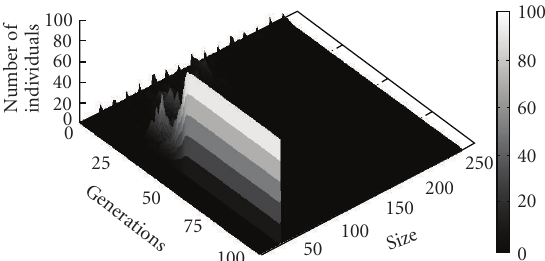
Figure 22: Parameter optimization Experiment 3: chromosome size in the population.